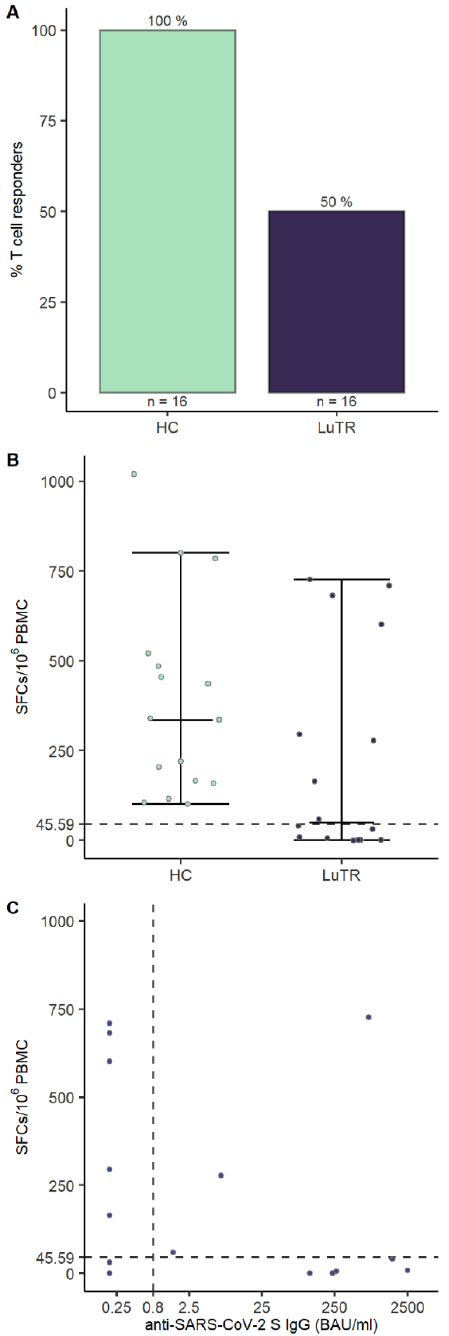
Figure 5. T cell responses to SARS-CoV-2 mRNA vaccination. T cell response rates and magnitudes in LuTRs and HCs: Bars indicate proportion of patients with a T cell response against SARS-CoV-2 peptide pools at 2–4 weeks after second vaccination dose ( A ). Circles represent individual T cell responses; y axis indicates the number of spot-forming cells (SFCs) per 10 6 PBMCs. Dashed lines indicates mean SFCs per 10 6 PBMCs + 3 times the standard deviation for spike peptide pool reactivity calculated from pre-pandemic controls ( B ). Scatterplot of humoral and cellular immune responses in LuTRs. The x axis represents Elecsys ® Anti-SARS-CoV-2 IgG titers (BAU/mL), with the vertical dashed line indicating the cutoff for seroconversion. The y axis represents SCFs per 10 6 PBMCs, with the horizontal dashed line indicating mean SFCs per 10 6 PBMCs + 3 times the standard deviation for spike peptide pool reactivity calculated from pre-pandemic controls ( C ).